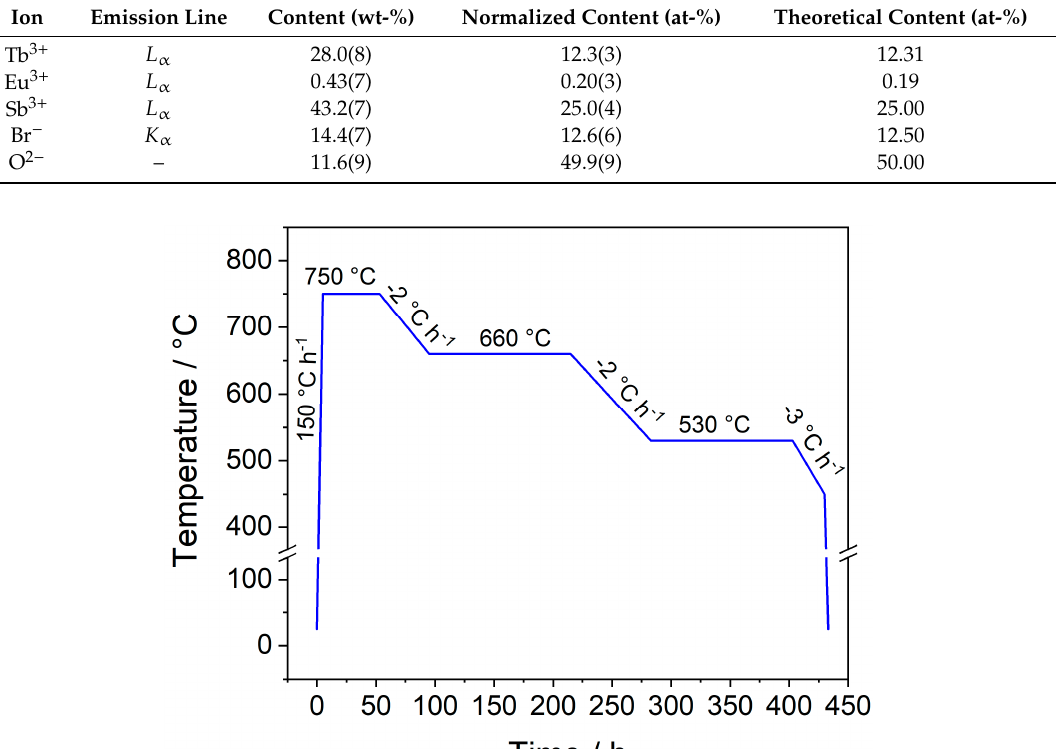
Figure A1. Applied multi-stage furnace program for the synthesis of single crystals with the composition Ln Sb 2 O 4 Br ( Ln = Eu ‒ Tb).